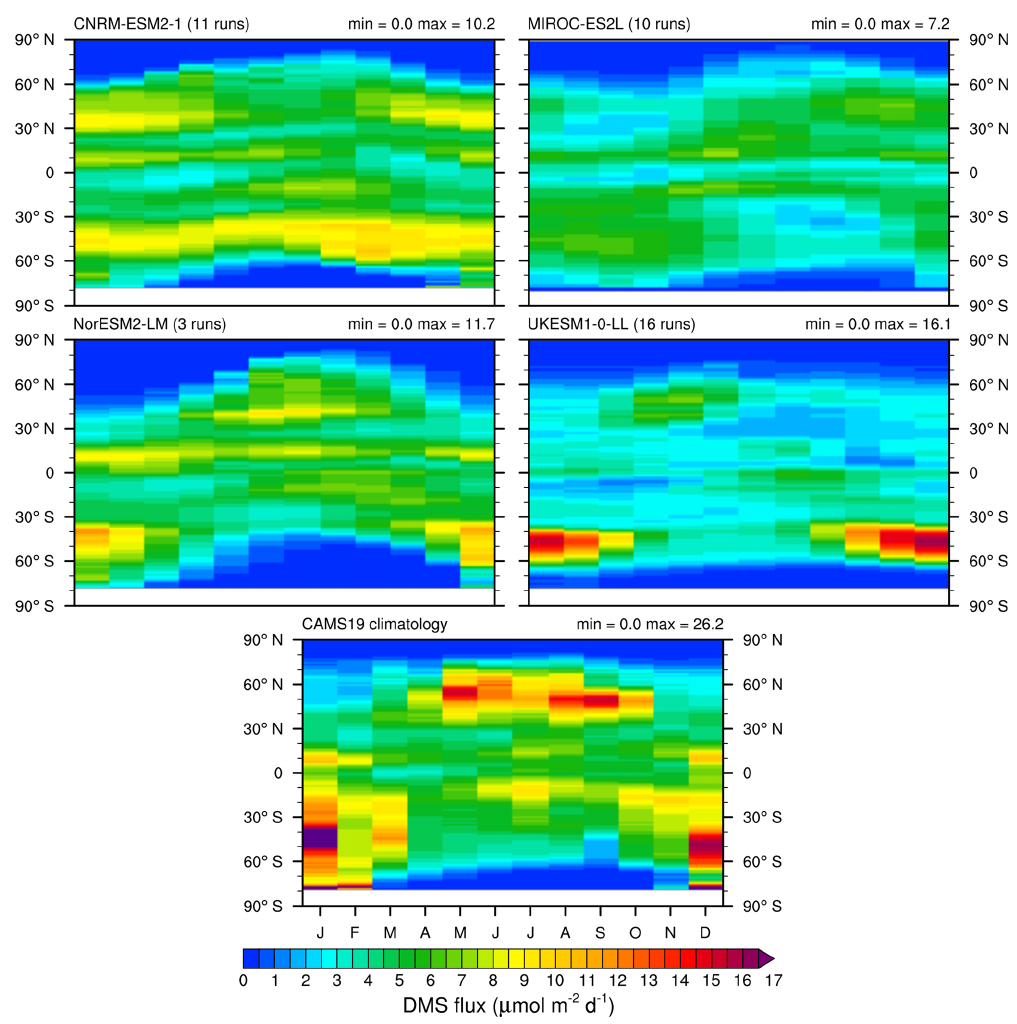
Figure 8. Monthly mean zonal DMS flux (µmolm − 2 d − 1 ) for the same models and datasets as in Fig.